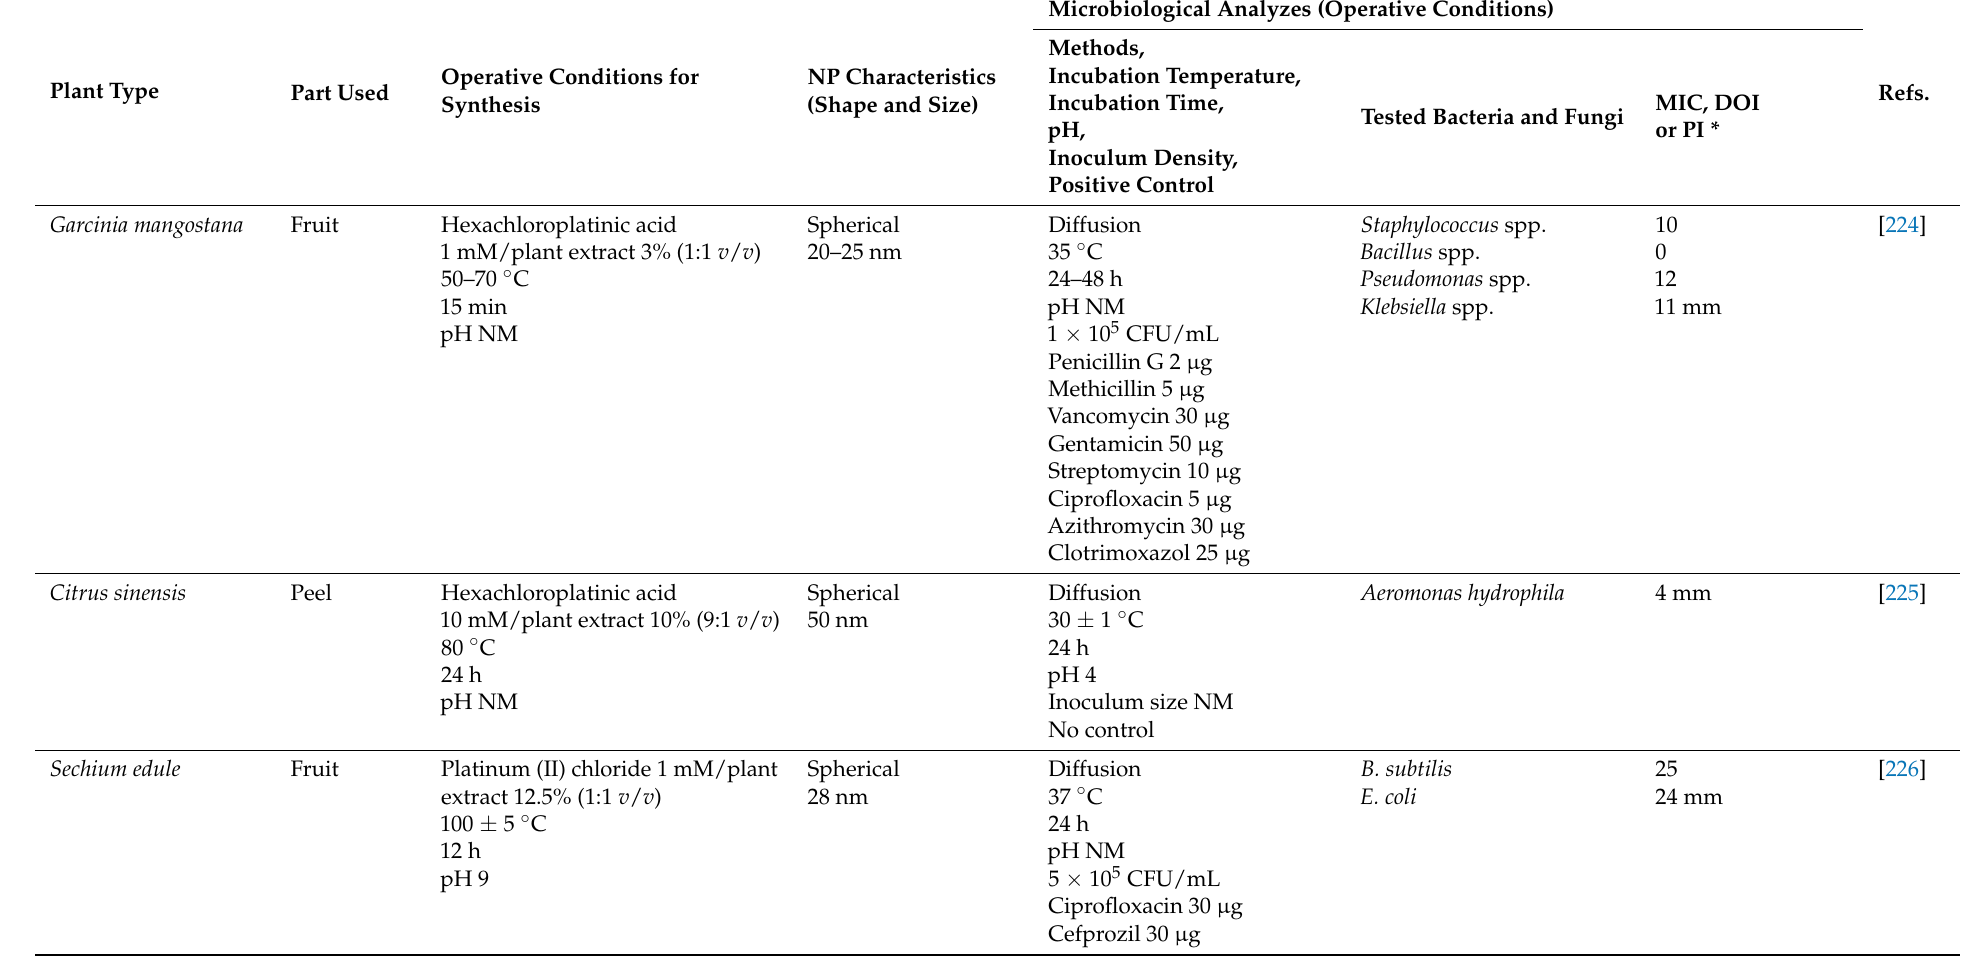
Table 5. Green platinum nanoparticles exhibiting antimicrobial